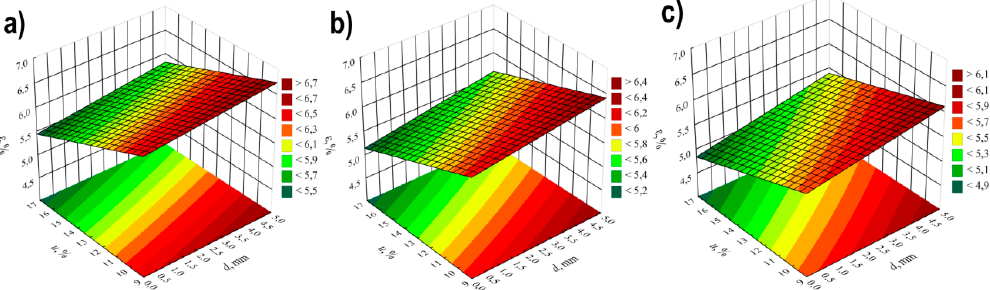
Figure 12. Response surface plots of elongation at tensile strength ε based on talc content and the distance between the kneading elements d at a screw speed n equal to: ( a ) n = 100 min − 1 ; ( b ) n = 250 min − 1 ; ( c ) n = 400 min − 1